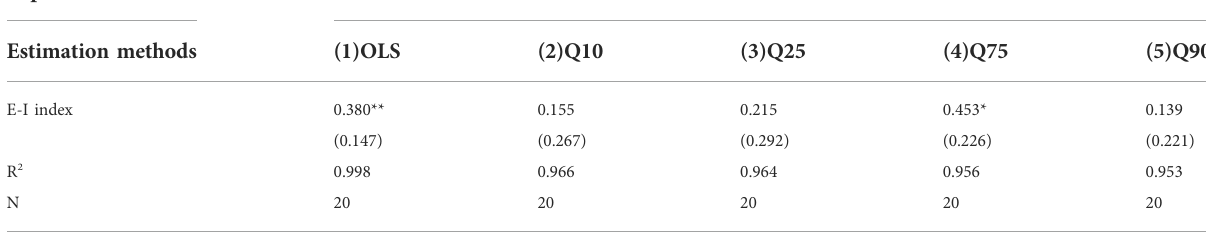
TABLE 6 Results of the regional network structure in fl uencing the effects. Explained variables